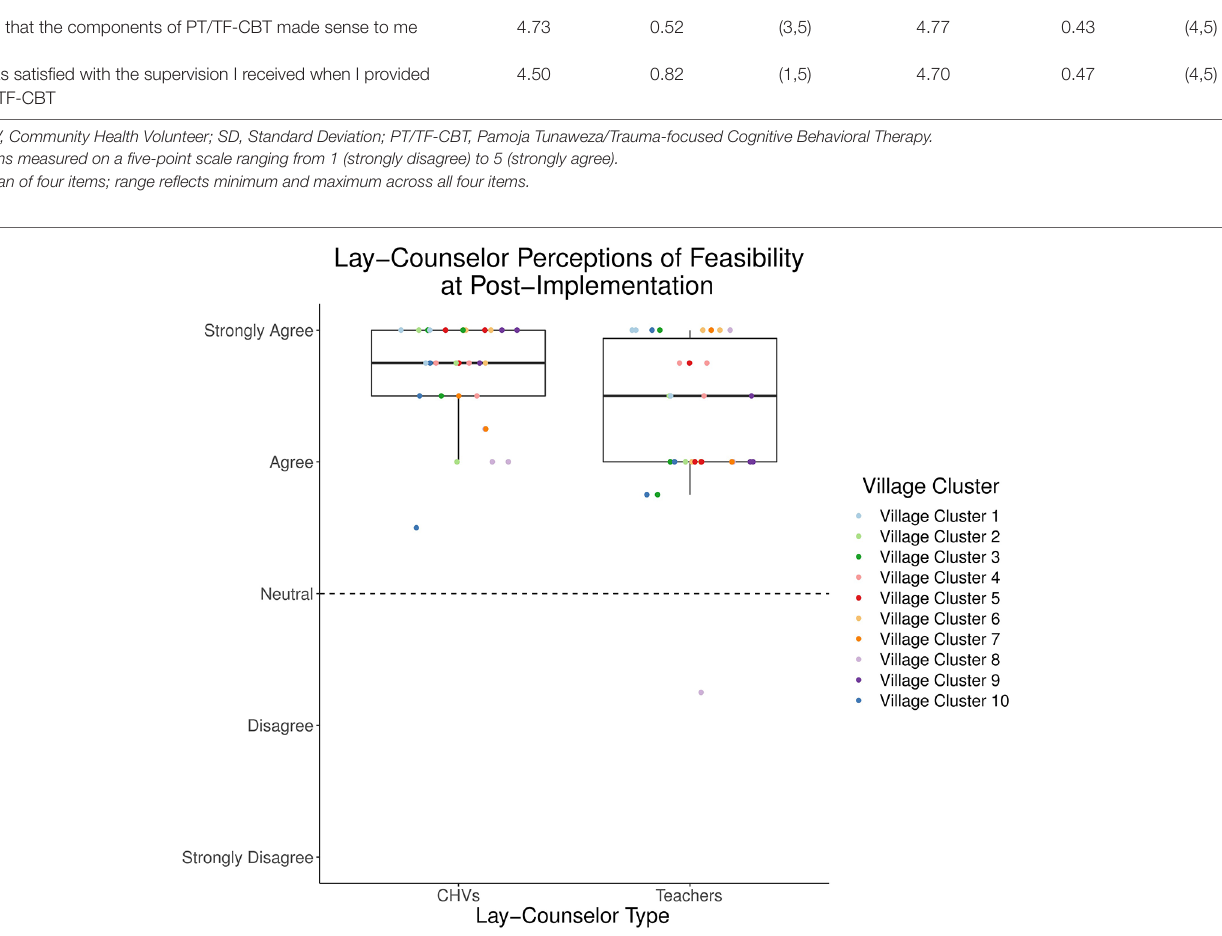
FIgUrE 3 | Lay counselor perceptions of intervention feasibility at